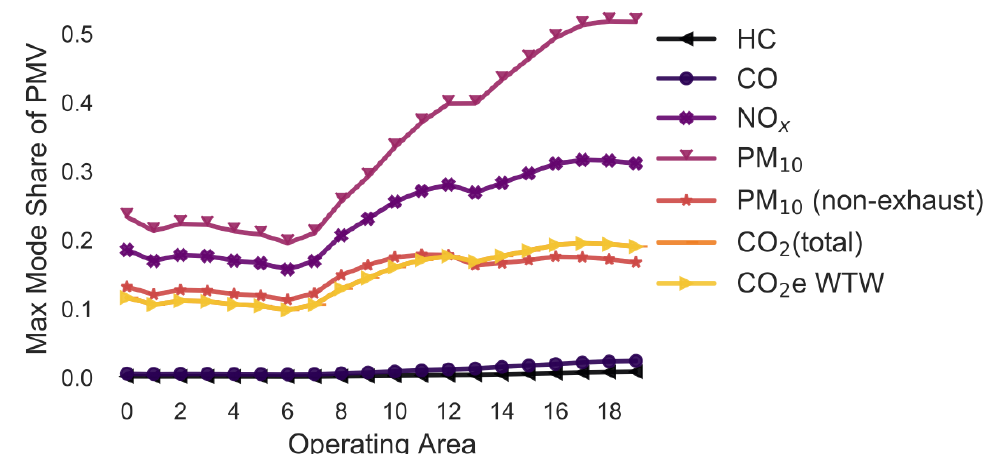
Figure 13. Maximum share of customers who can pick up a parcel by car (varying parking dura- tion before customer trip) (note: CO 2 (total) and CO 2 e WTW are the same).